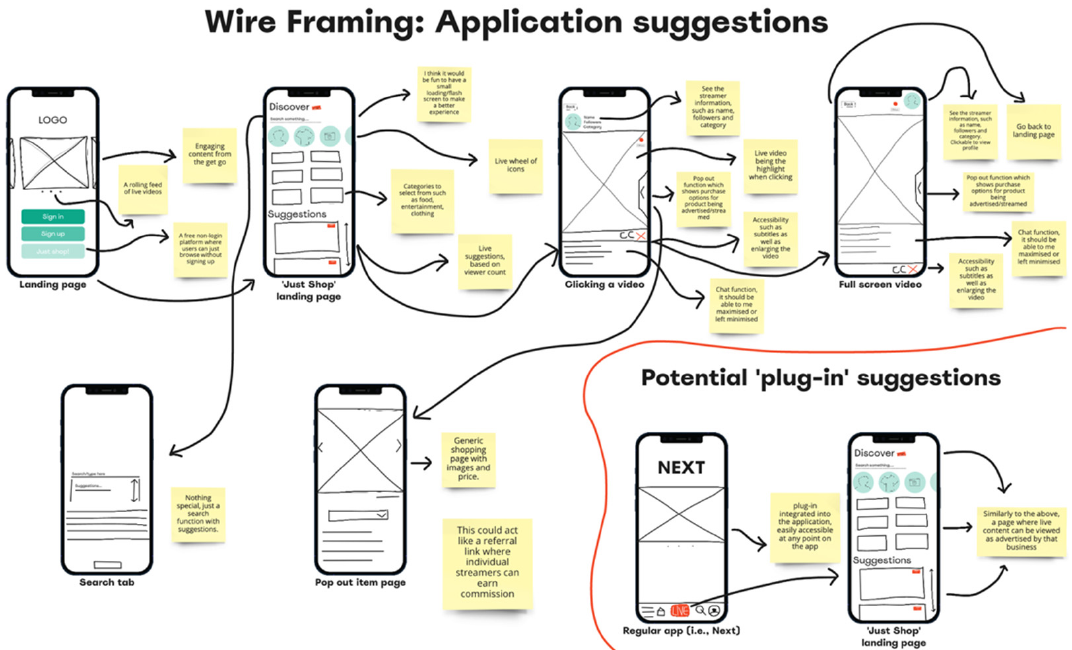
Figure 12. A screenshot from the Co-Design Workshop Miro board, illustrating wire frame/proto- type suggestions developed by the participants.